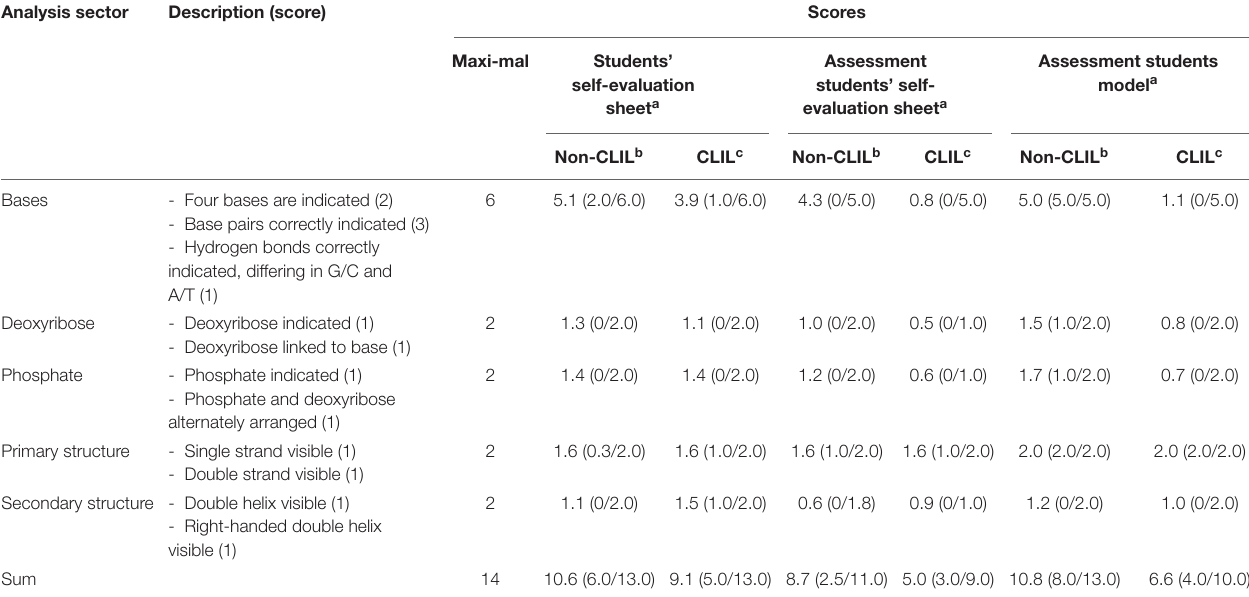
TABLE 3 | Assessment of the evaluation-2 phases in the non-CLIL and CLIL approaches.